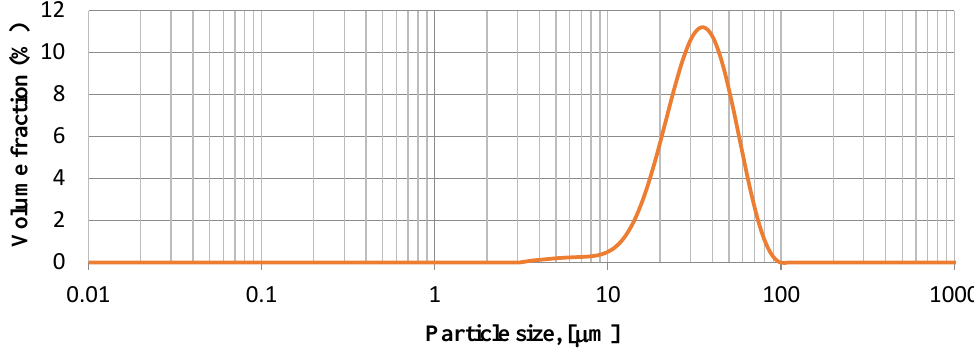
Figure 2. Particle size distribution of titanium powder.